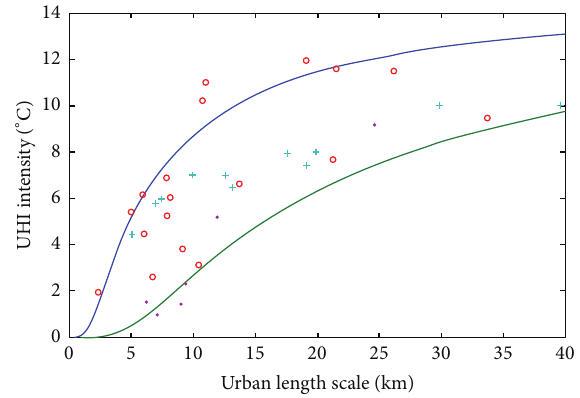
Figure 3: UHI intensity as a function of the urban length scale. Symbols represent data as reported by Oke [9]. The upper curve is (3) with 𝐾 = 1.0 , while the lower is for 𝐾 = 0.25 .